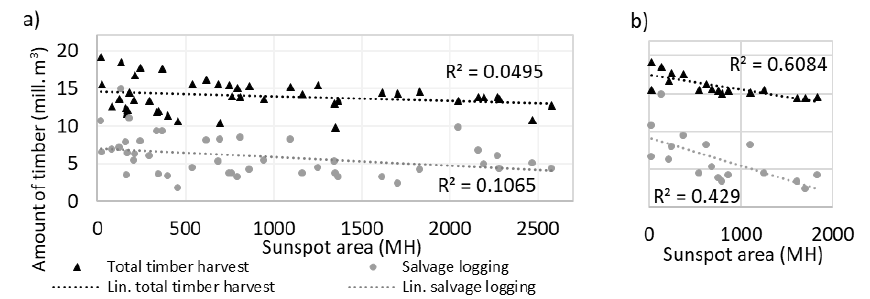
Figure 7. Scatter plot: Average annual sunspot area in relation to salvage logging and the total volume of timber harvested in the Czech Republic in the periods ( a ) 1973–2018 and ( b ) 2000–2018; explanatory